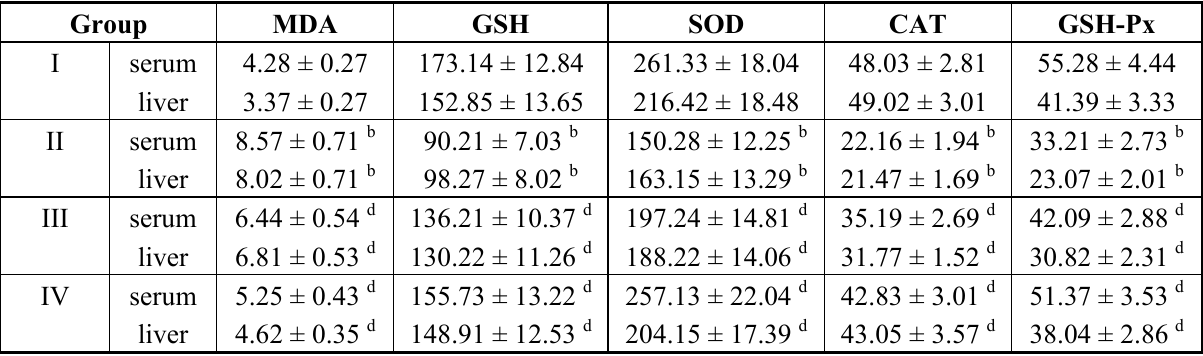
Table 4. Sodium aescinate injection liquid affecting serum and liver MDA, GSH, SOD, CAT and GSH-Px